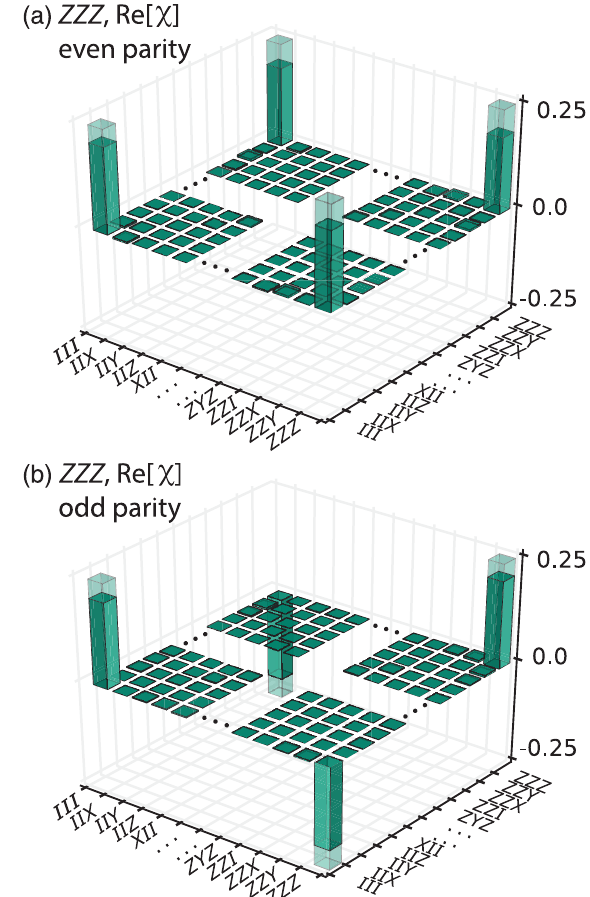
FIG. 5. Three-qubit conditioned quantum process tomography. Experimental quantum process tomography results for (a) even and (b) odd outcome process maps for the three-parity measure- ment, ZZZ . We express our process tomography in the Pauli basis where the conditioned processes can be described using χ matrix P χ 0 ð 1 Þ σ ρ σ notation: F 0 ð 1 Þ ð ρ , where f σ g are the three- r Þ ¼ i r j ij ij qubit generalized Pauli operators. Here, we show only the corners of these process matrices, all other parts are visually indistin- guishable from noise. Data on the full reconstruction, including of the other six measurement operators, are given in the Supplemental Material [32]. The ideal even and odd outcome processes are projectors Π 0 ð 1 Þ ¼ ð III (cid:3) ZZZ Þ = 2 , and the corre- sponding χ matrices have a simple form consisting of only four real components in the generalized Pauli basis, and this ideal form is overlaid with wire frame bars. Note that we plot only the real components as all experimental imaginary components are visually indistinguishable from noise. We calculate the J fidelity (as defined in Sec. III F) for this operator to be